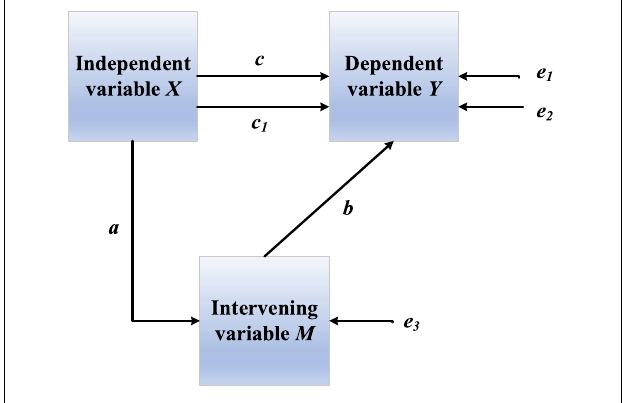
FIGURE 6 | Relationship diagram of variables in mediating effect.